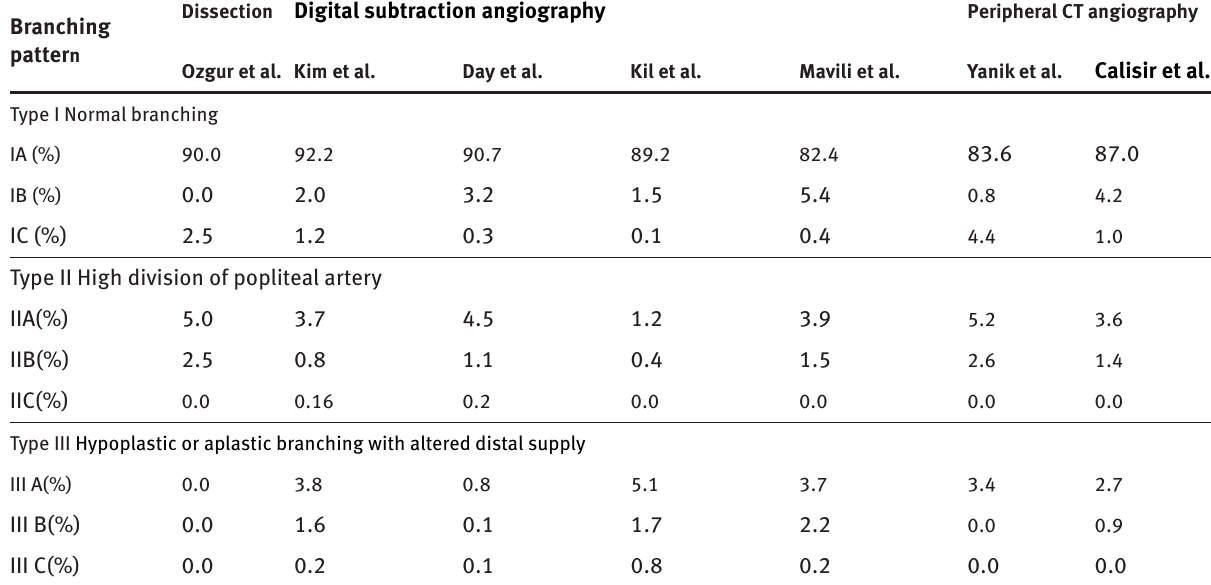
Table 3: Distribution of variations in the branching pattern of the popliteal artery among various studies